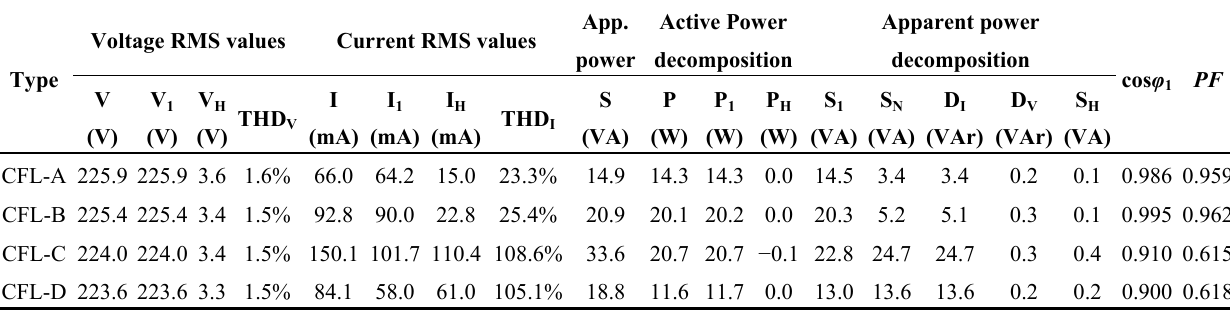
Table 4. Power quality analysis of the measurements results for compact fluorescent